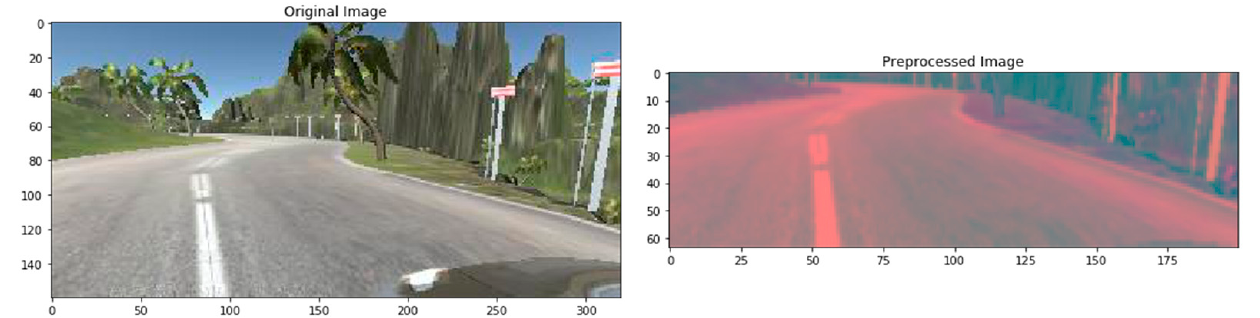
Figure 15. Pre-processed image.